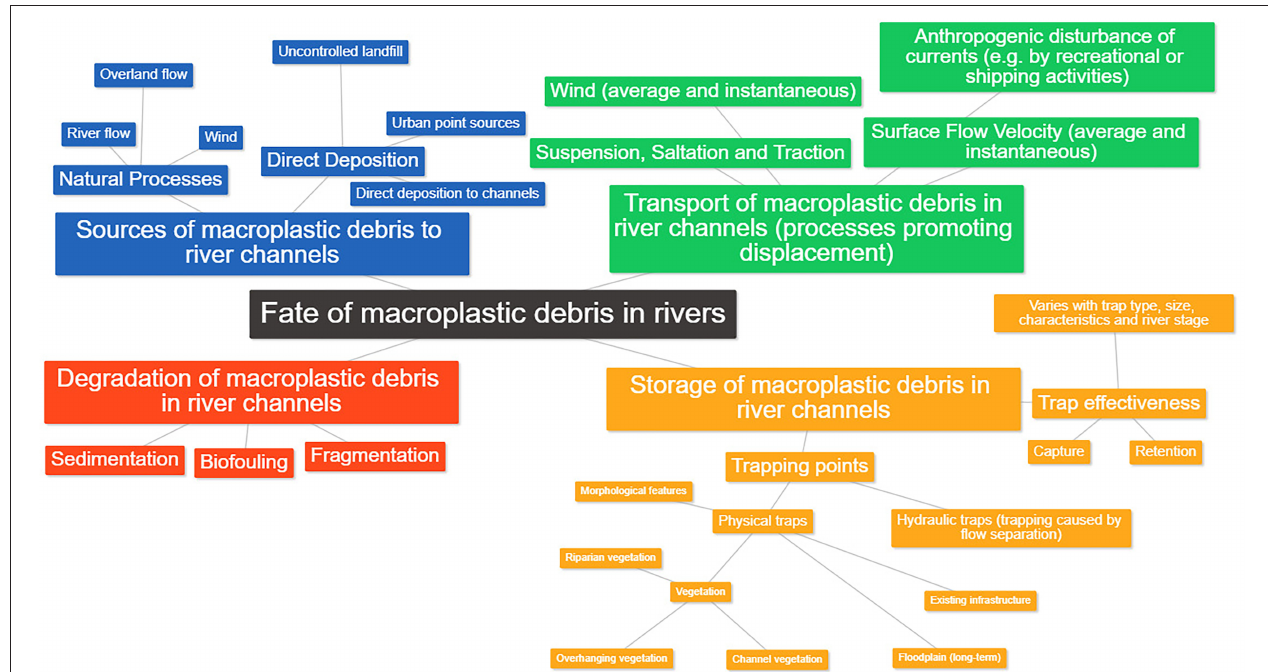
FIGURE 1 | Processes controlling the fate of macroplastic debris in rivers, including: the sources, transport, degradation, and storage of macroplastic debris in river